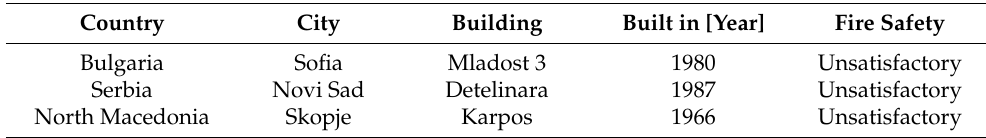
Table 4. Analysed three large panel system residential towers in terms of reliability (based on the information provided in [58]) .